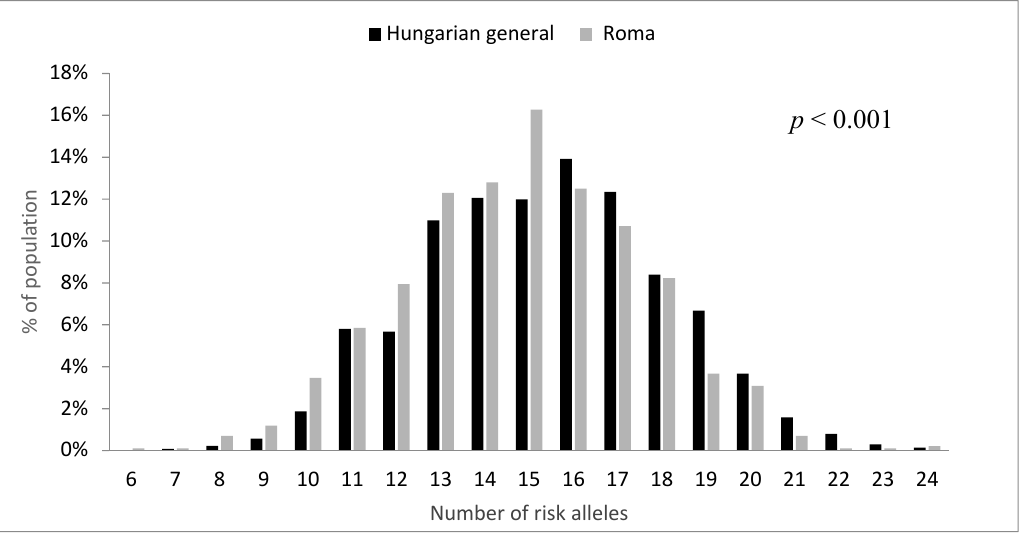
Figure 2. Distribution of unweighted genetic risk scores based on 16 SNPs by study population samples. The average wGRS in the Roma group was 1.36 ± 0.31, while it was 1.41 ± 0.32 in the General population. The distribution of wGRSs was significantly ( p < 0.001) di ff erent between the study populations, which is shown in Figure